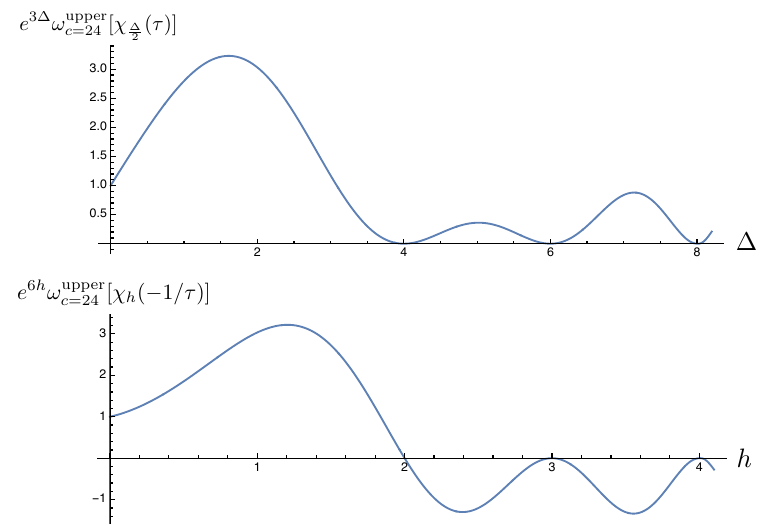
, defined in (5.8), on the bulk (upper plot) and c =24 [ χ ( τ )] and e 6 h ω upper [ χ h ( − 1 /τ )] . ∆ c =24 c =24 2